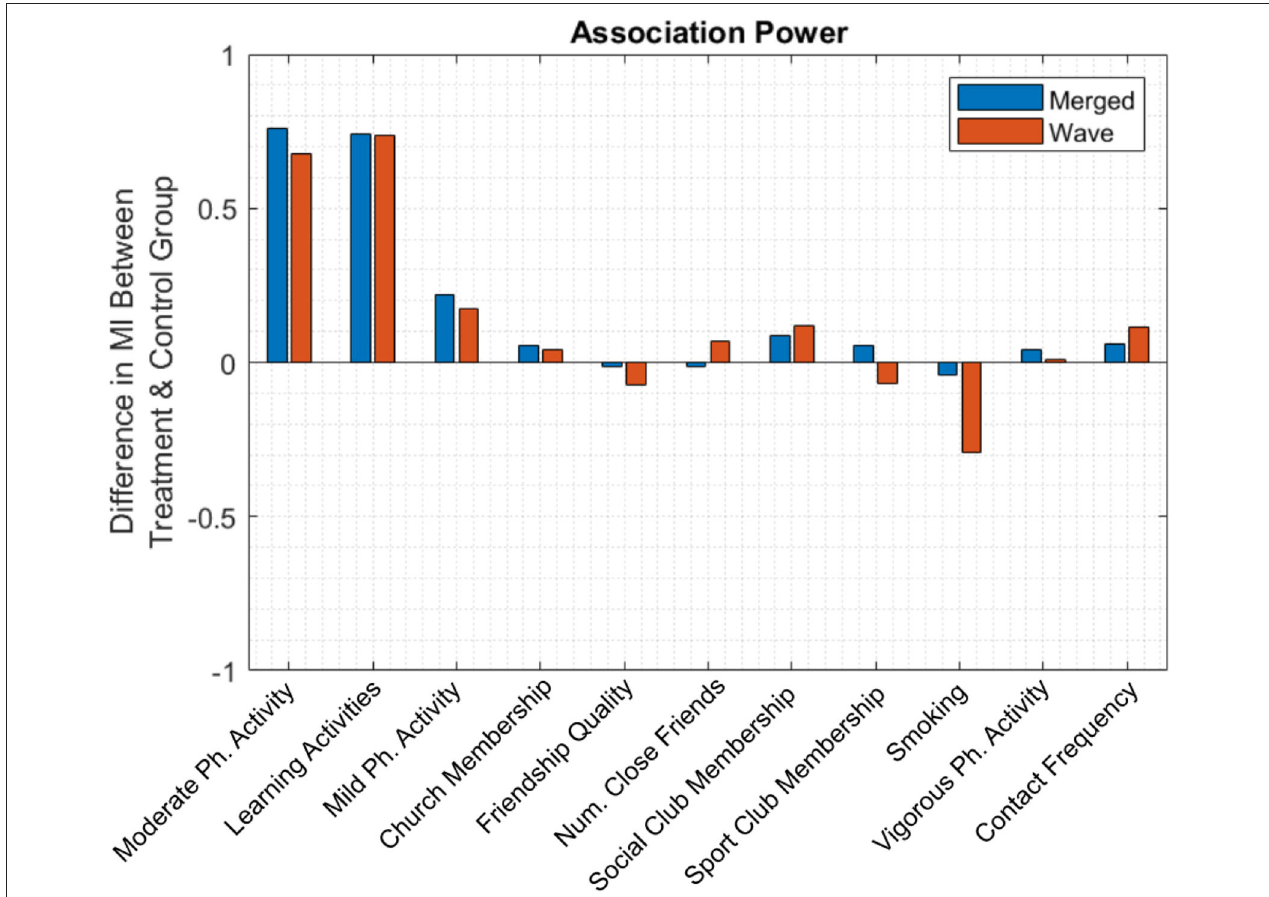
FIGURE 5 | The mean difference in MI between treatment and control group. Engagement in moderate-intensity physical activity and learning activities leads to approximately 0.75 points increase in